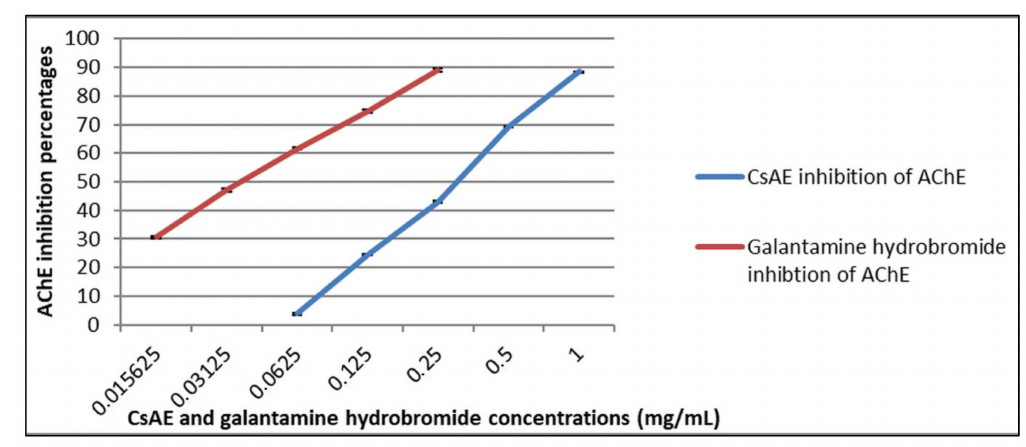
Figure 3. Inhibition percentages of acetylcholinesterase (AChE) exhibited by di ff erent concentrations of CsAE (0.0625–1 mg / mL) and galantamine hydrobromide (0.015–0.25 mg / mL). Coe ffi cient and Regression equation of inhibition displayed by CsAE: y = 21.398 x − 61.181, R 2 = 0.9972, IC 50 = 0.29 ± 0.004 mg / mL. Coe ffi cient and Regression equation of inhibition displayed by galantamine hydrobromide: y = 14.406 x + 17.386, R 2 = 0.9985, IC = 0.03 ± 0.0005 mg / 50